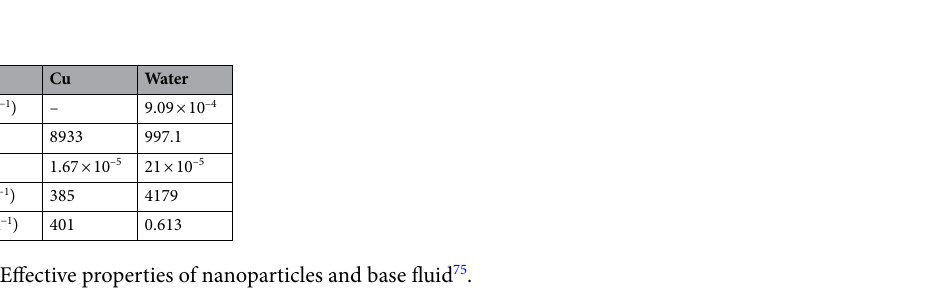
Table 1. Conditions of the boundaries for the flow model 22,38 , where ‘ a ’ indicates normal direction to the surface.